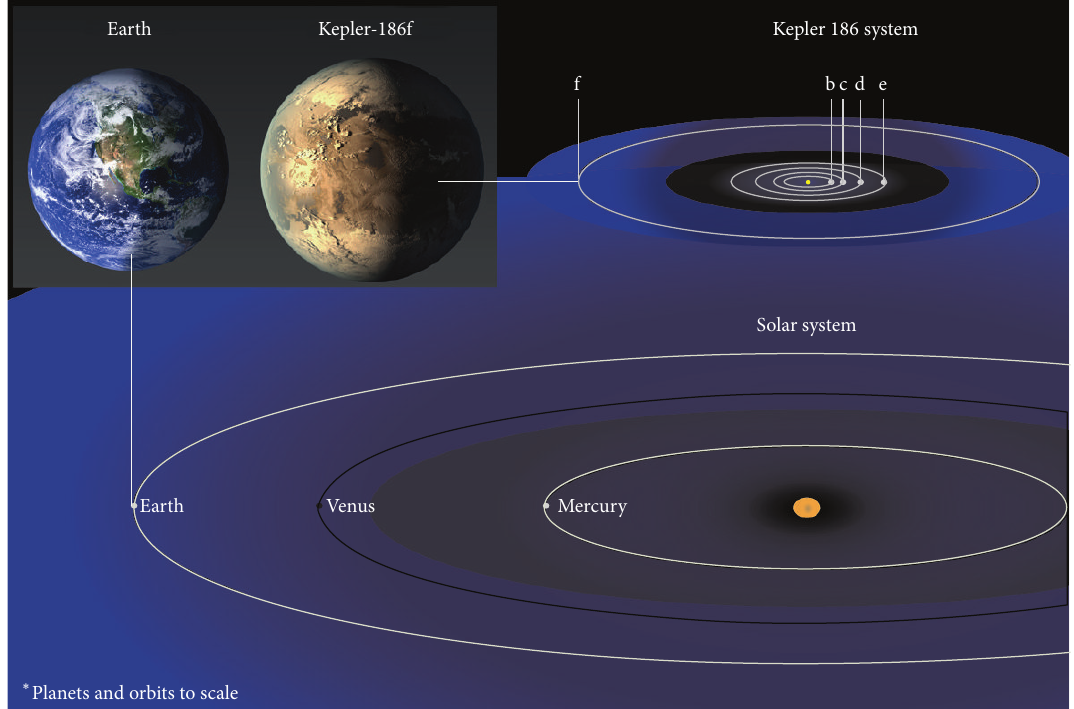
Figure 9: Schematic artistic representation of Kepler-186 multiple system compared with the inner solar system. Kepler-186 is a five-planet system located ∼ 500 light-years away orbiting an M star half the Sun mass (Quintana et al. [51]) (credits: NASA Ames/SETI Institute/JPL-